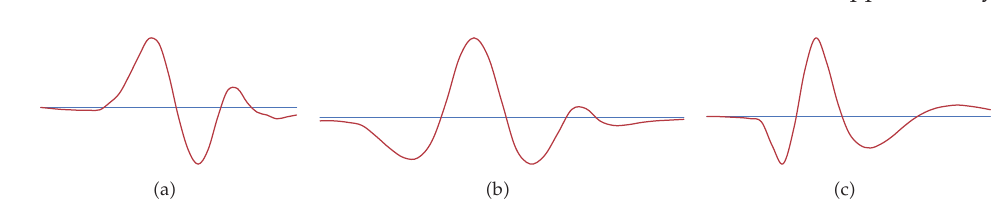
Figure 1: (cid:2) a (cid:3) Tsunami 52406 from DART, March 2011; (cid:2) b (cid:3) replica of tsunami-model profile adapted from (cid:2) t (cid:3) for q (cid:5) 1 . 5. (cid:6) 7 (cid:7) ; (cid:2) c (cid:3) MADE solution profile y (cid:5) K q